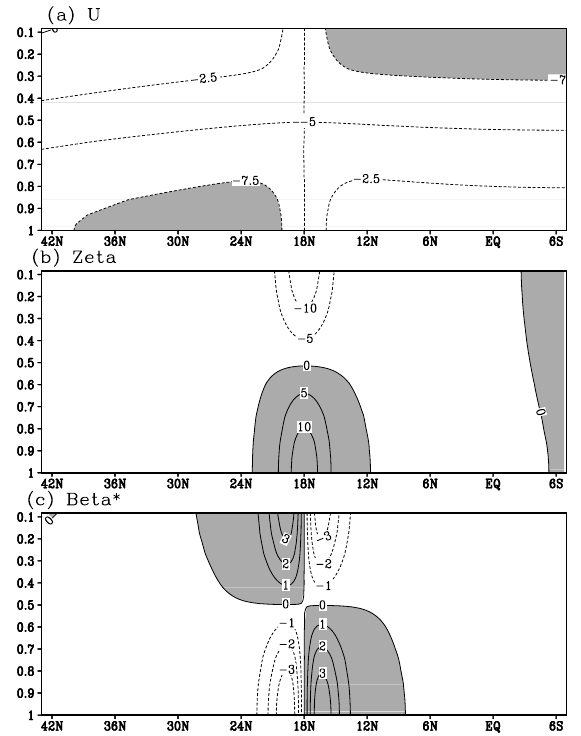
Fig. 1. Latitude-height distributions of the idealized basic zonal flow (top, ms − 1 ) , the corresponding relative vorticity (middle, 10 − 6 s − 1 ) and the meridional gradient of the relative vorticity (bottom, 10 − 11 m − 1 s − 1 ) . The ordinate is σ and the abscissa is latitude.